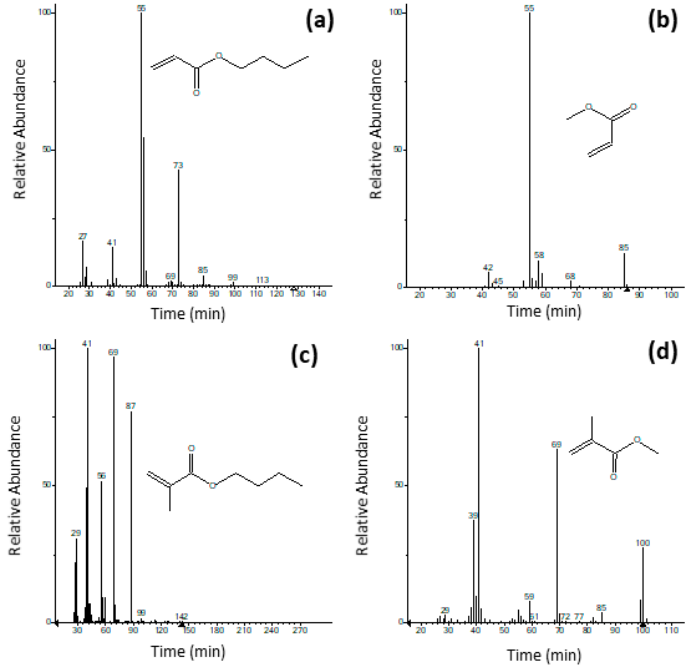
Figure 3. M / z spectra of ( a ) n -butyl acrylate, ( b ) methyl acrylate, ( c ) n -butyl methacrylate, ( d ) methyl